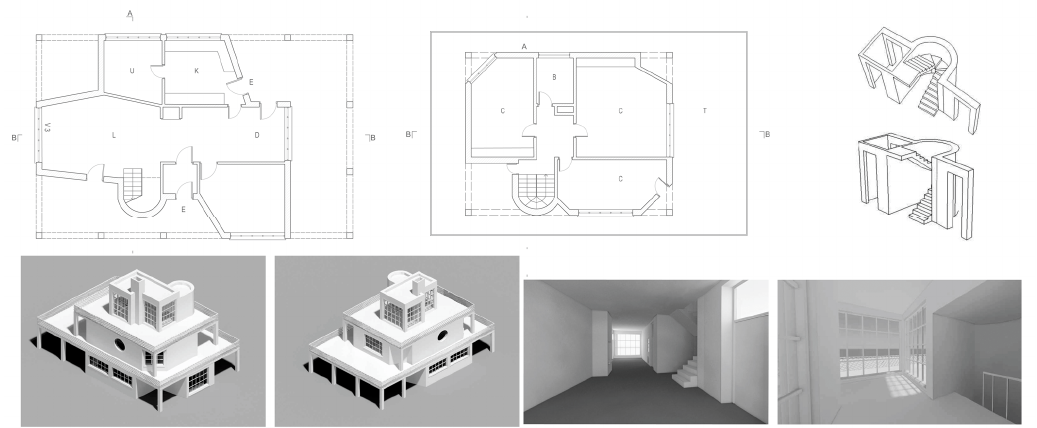
Figure 8. House 4. Plans, schemes, axonometric view, perspective (C.